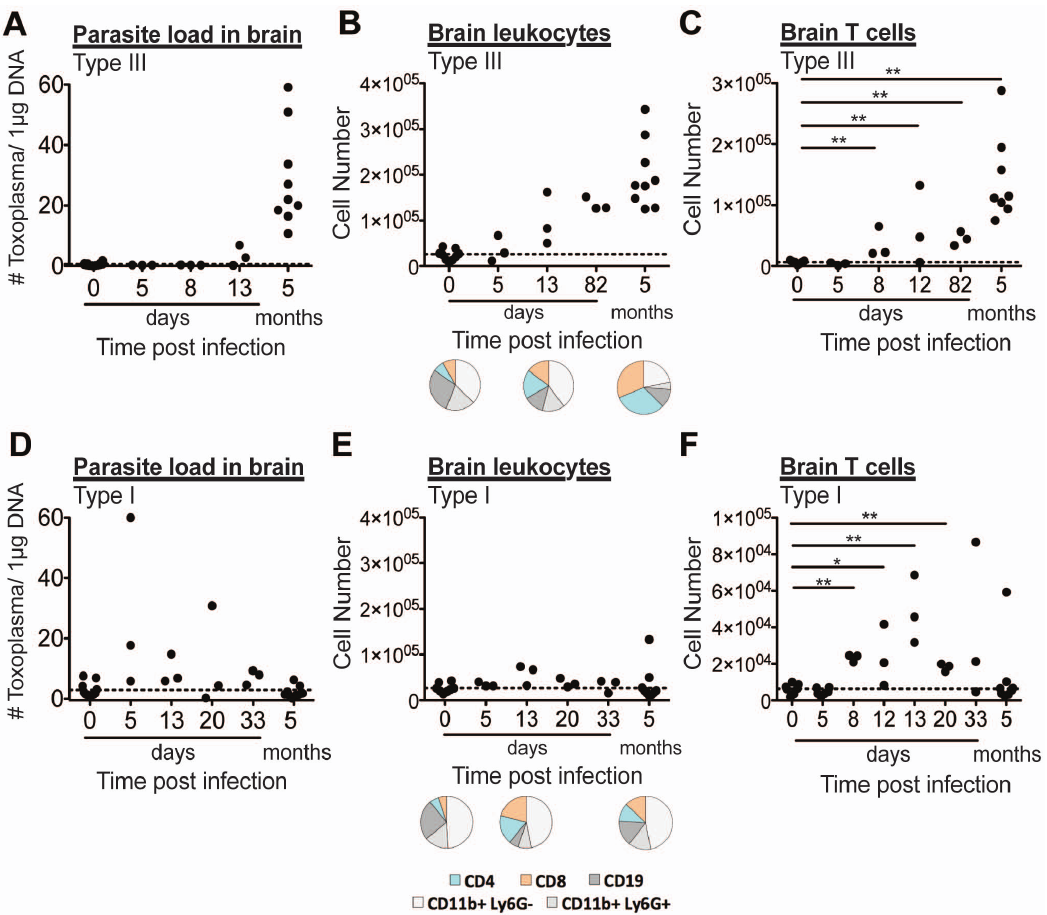
Figure 3. Type I and Type III acute infection results in parasite and leukocyte infiltration of the brain region. [A and D] Parasite presence was assessed using semi-quantitative PCR of genomic DNA prepared from 10% of each mouse brain and meninges at various times post infection. For reference, data from Figure 2A is included which was collected from animals that were used in behavior experiments 4 to 5 months post infection. [A] Type III-infected animals have detectable parasite in brain regions early during acute infection, which is sustained over time. [D] Some attenuated Type I-infected animals have detectable parasite in brain regions early during acute infection, decreasing to undetectable levels (average of uninfected indicated by black dashed line). [B and E] Brain leukocytes were percoll purified from the remaining brain and meningeal homogenate, stained for leukocyte surface markers CD4, CD8, CD19, CD11b, and Ly6G, and assayed using flow cytometry. [B] Type III-infected animals have brain leukocyte numbers above uninfected levels (black dashed line) 13 days following infection which continue to increase over time. [E] Average total cell numbers from Type I-infected animals. Average percentages of brain leukocyte populations for uninfected, Type I-, and Type III- infected animals at selected time points are represented in pie charts below the corresponding data in [B and E]. [C and F] Total brain and meningeal T cells (CD4 plus CD8), indicators of brain region inflammation, are reported for Type III- and attenuated Type I-infected animals. Each dot signifies one mouse. Significance was determined for [C and F] by Student’s T-test where * indicates p , 0.02, and ** indicates p ,